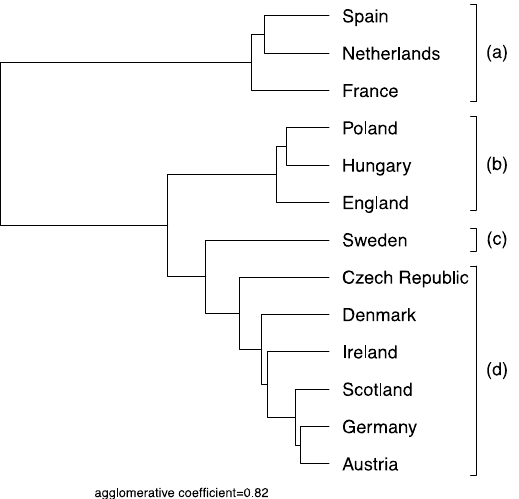
Figure 2. Dendrogram clustering 13 member states on WFD-related governance change. Agglomerative clustering, using nine previously described variables measured for two points in time (see Section 3 and Supplementary Material), Gower’s general dissimilarity coefficient, and Ward’s method of agglomeration.